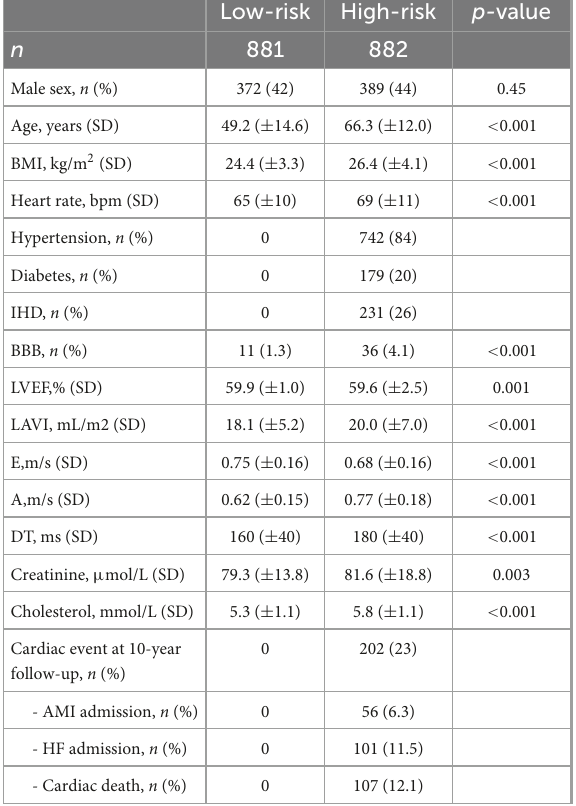
TABLE 1 Population characteristics.